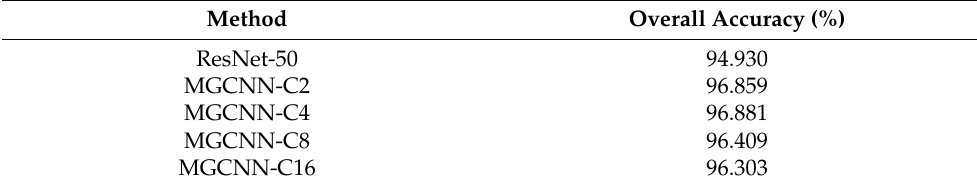
Table 3. Overall accuracy (OA) of MGCNN.